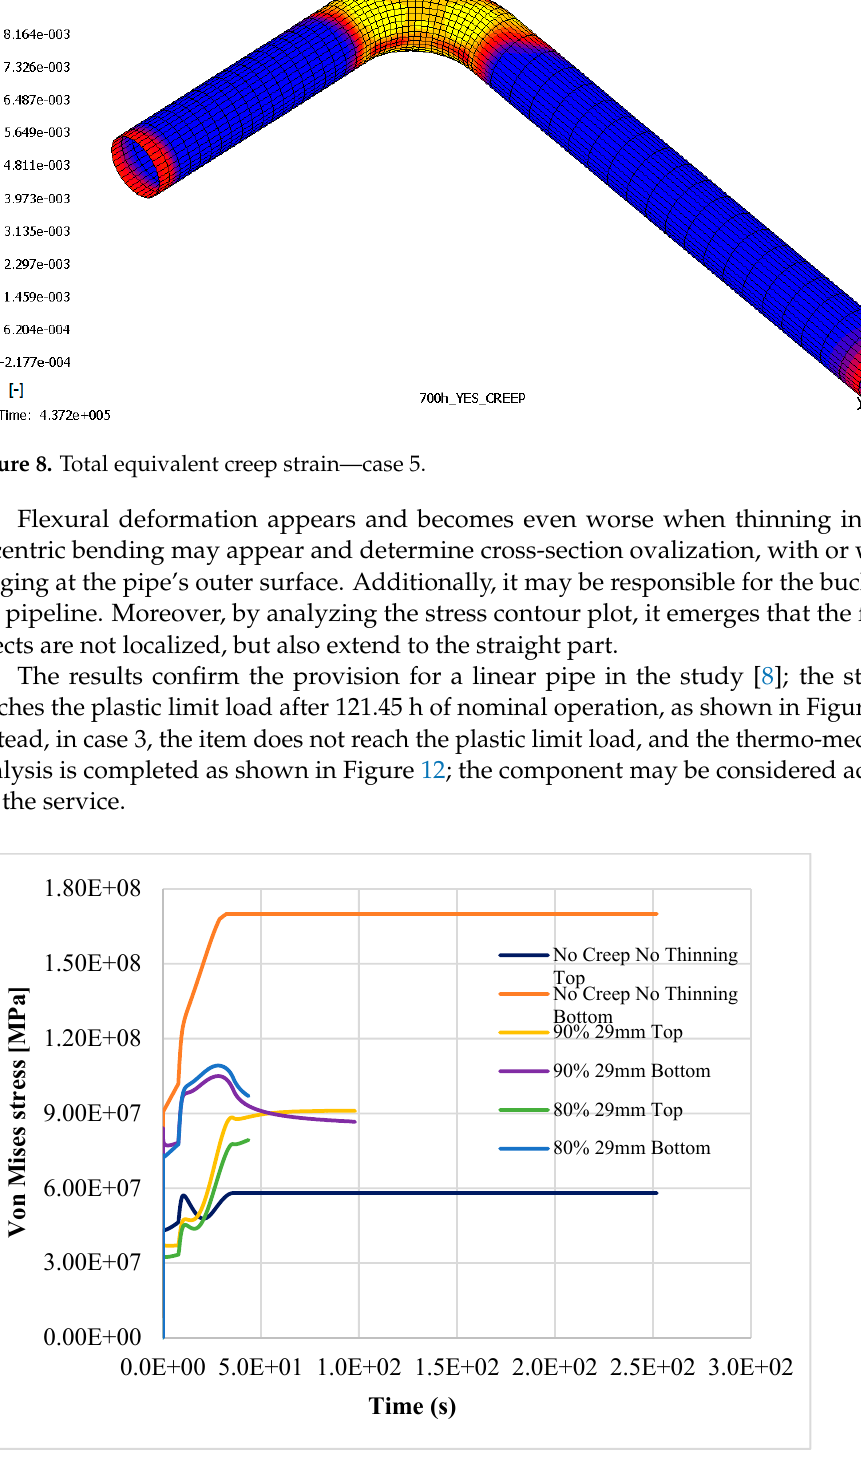
Figure 7. Equivalent von Mises stress, bottom layer—case 5.